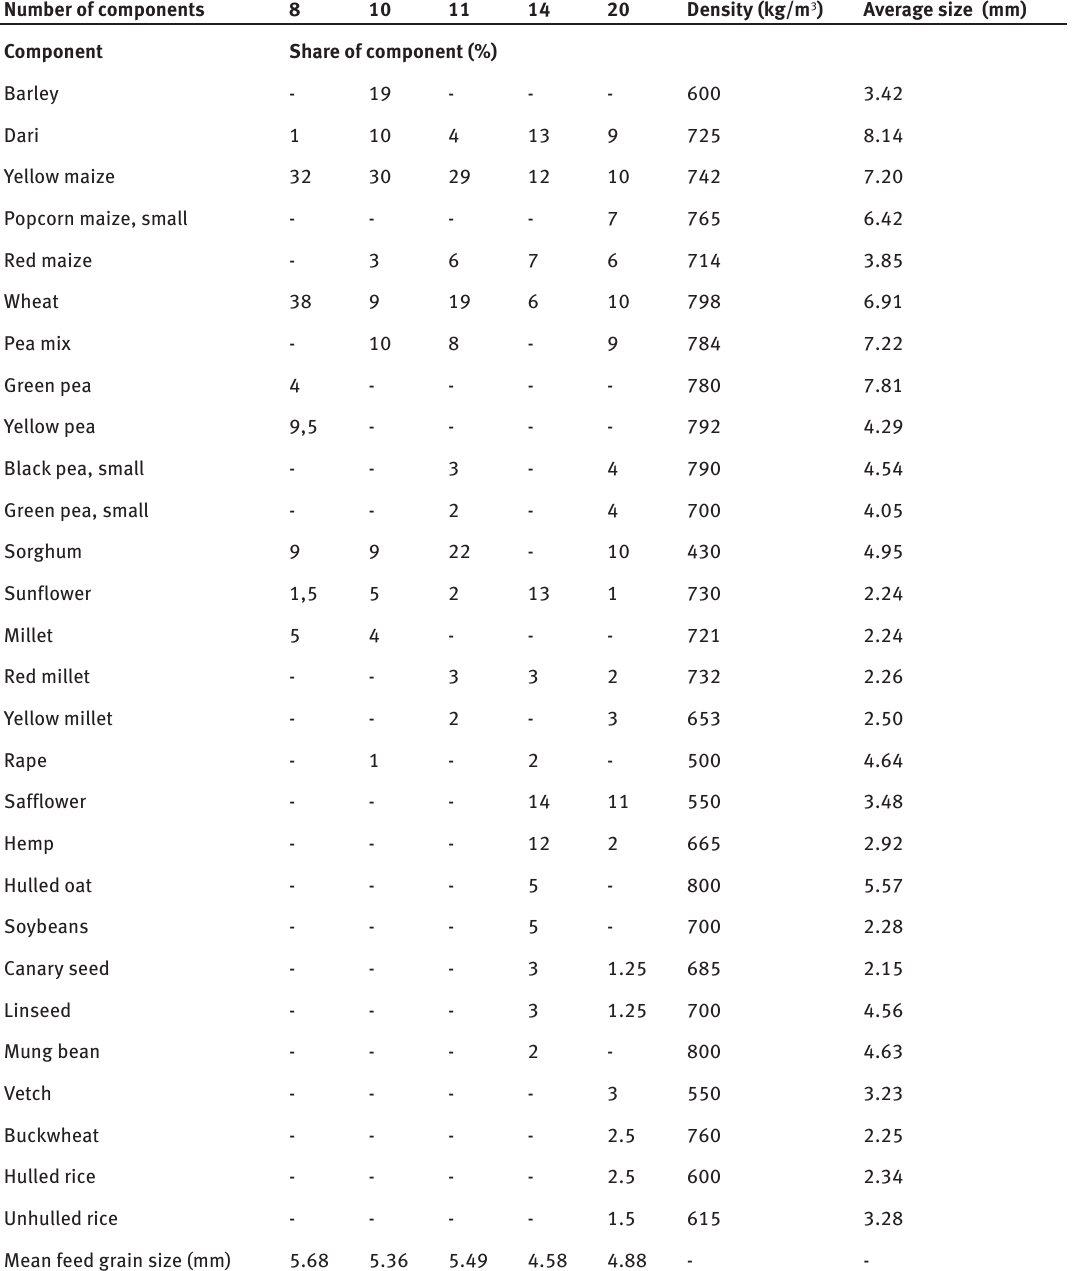
Table 1: Composition of study